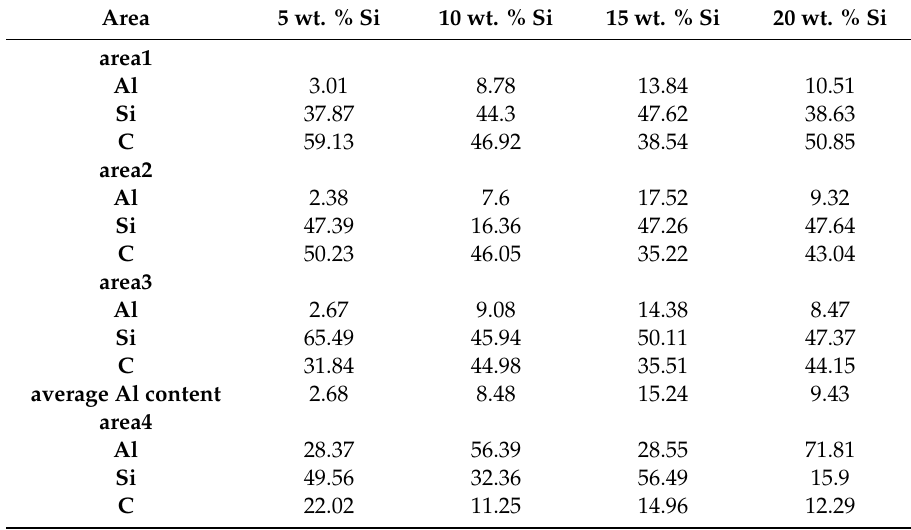
Figure 4. SEM image of the SiC ceramic infiltrated by Al alloy with different Si content: ( a ) 5 wt. %, ( b ) 10 wt. %, ( c ) 15 wt. %, and ( d ) 20 wt. %. Table 2. Chemical composition of marked areas on Figure 4, obtained by energy-dispersive X-ray spectroscopy (EDS).